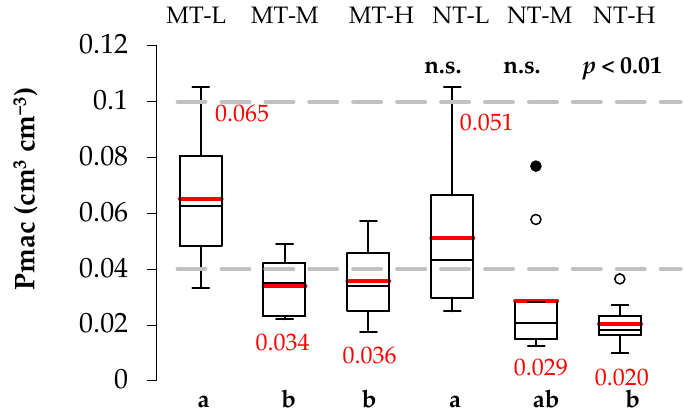
Figure 5. Box plots of macroporosity ( Pmac ) corresponding to low (L), intermediate (M) and high (H) runs, under minimum tillage (MT) and no-tillage (NT). The thick red line on each box represents the mean value, and the thin black line represents the median; the former is also reported with numbers. White circles represent outliers (extreme outliers in black). Interval between the dashed lines represents the optimal values of Pmac according to Reynolds et al. [21]. For a given soil management practice, mean values of water height followed by the same letter are not statistically different according to a Tukey HSD test; for a given water height, differences in soil management were reported according to a two-tailed t -test (n.s. = not significant).